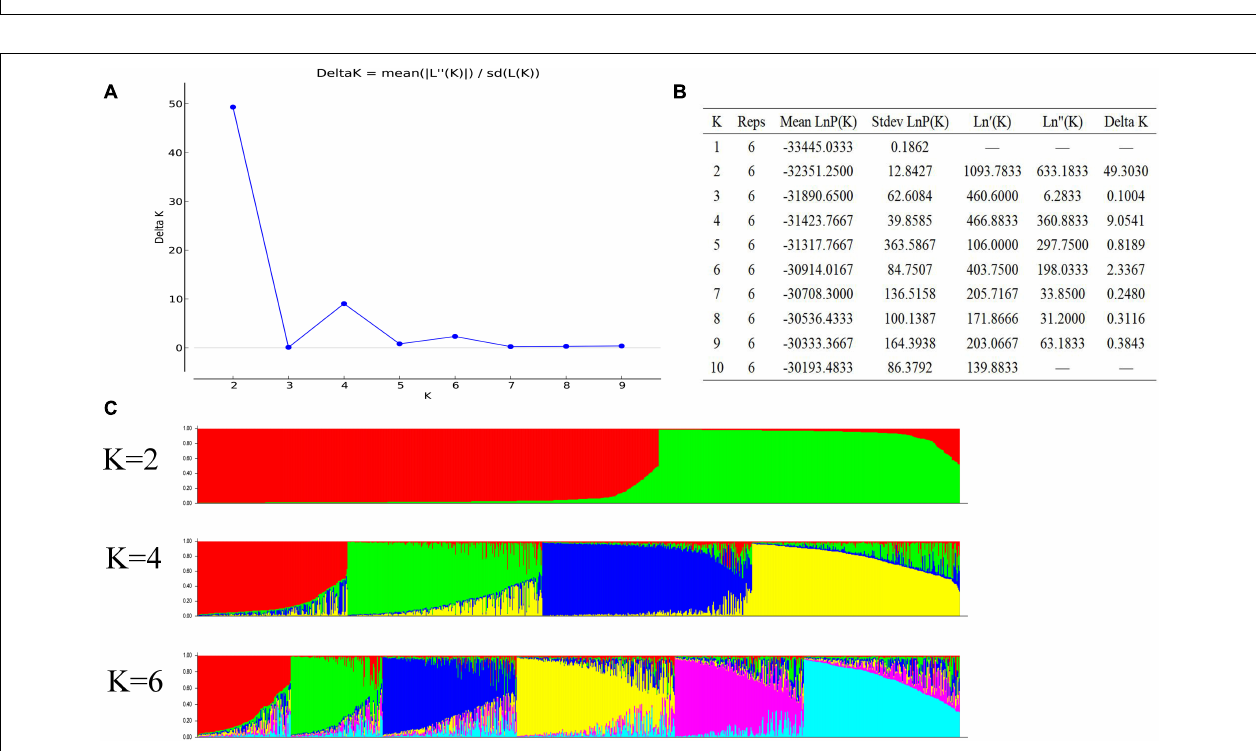
FIGURE 2 | Population structure analysis of the 955 A. trifoliate accessions. (A) Delta K based on the rate of change of L (K) between successive K -values. (B) Evanno table output. (C) Population structure based on K = 2, 4, 6.